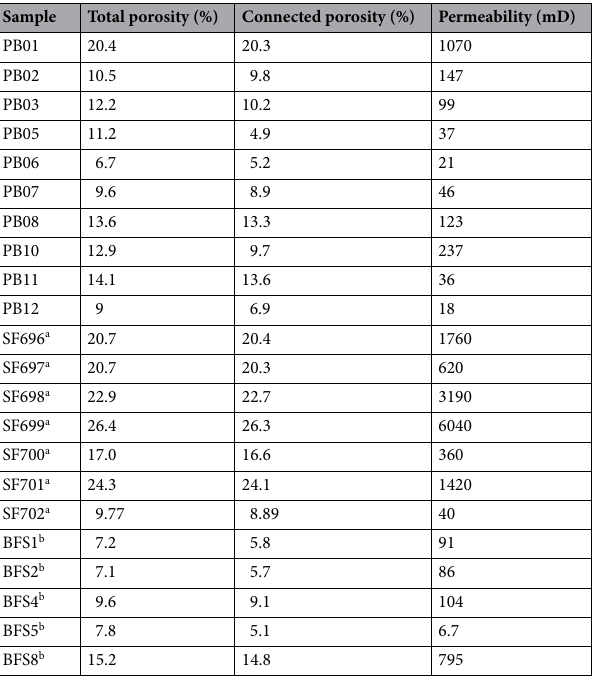
Table 2. Porosity and permeability measurements made for each sample. a Payton et al. 17 . b Thomson et al. 18